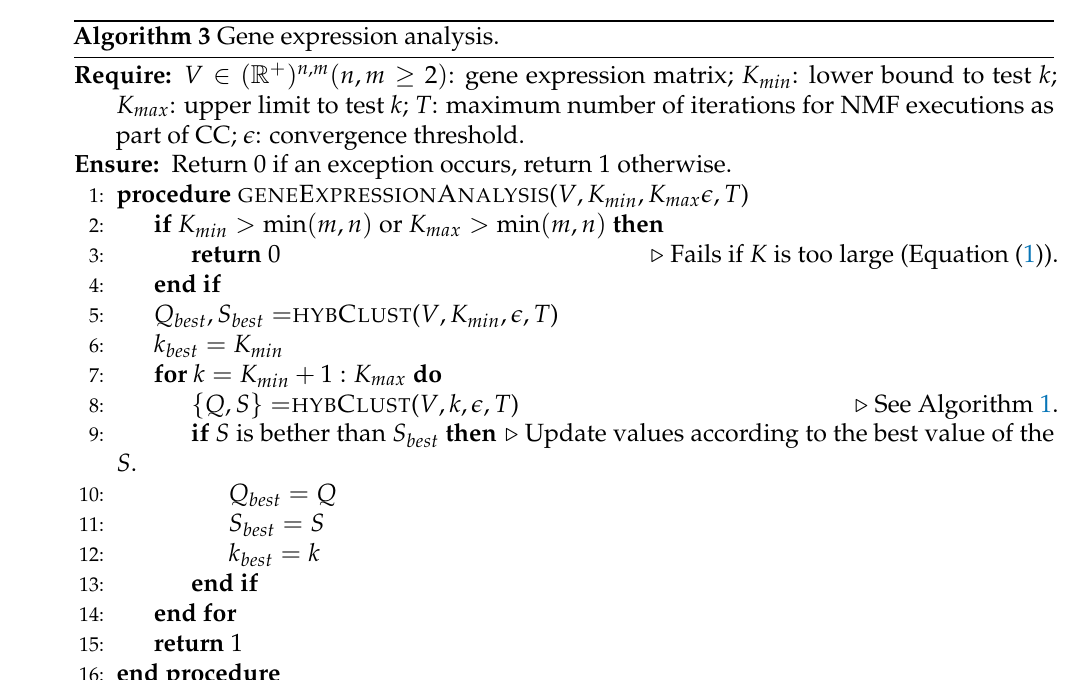
Algorithm 4 is, properly, an NMF algorithm. Given three parameters, V ∈ ( R + ) n , m ( n , m ≥ 2 ) , representing a gene expression dataset, k such that 2 ≤ k ≤ min ( n , m ) represented the current number of clusters, and the convergence threshold (cid:101)